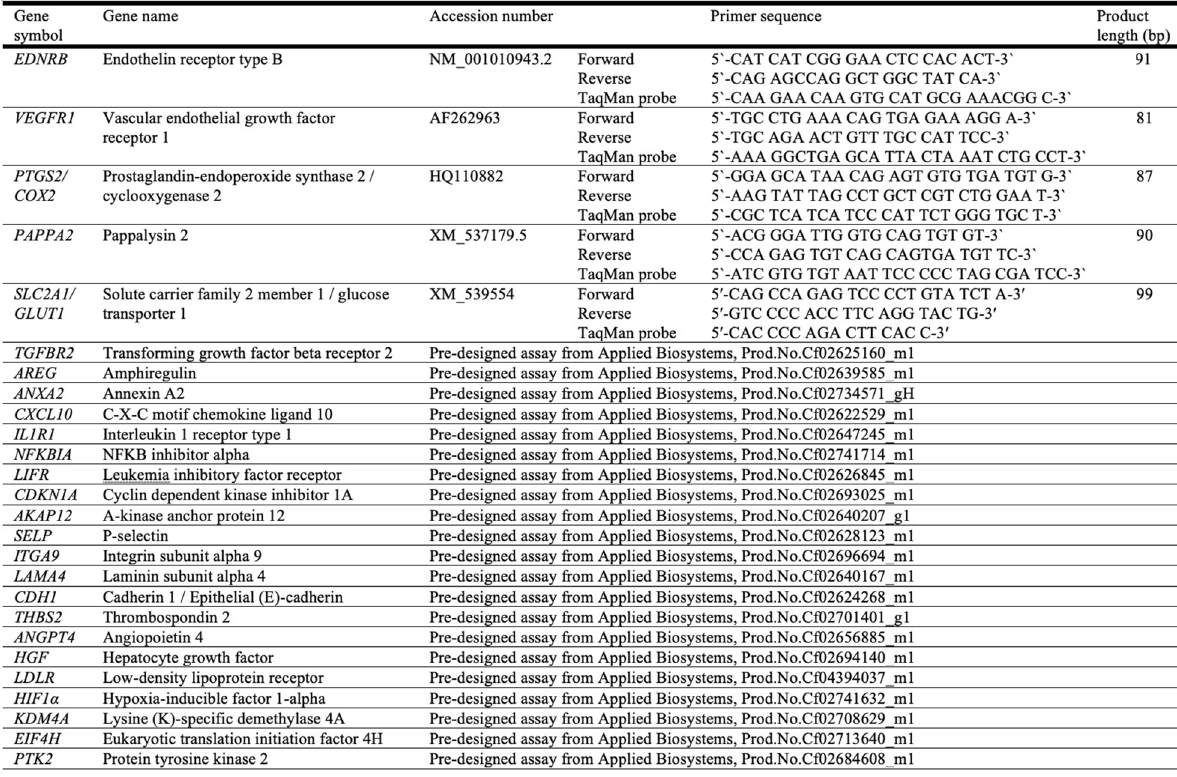
Table 2. List of symbols, corresponding gene names and TaqMan systems used for semi-quantitative real-time TaqMan